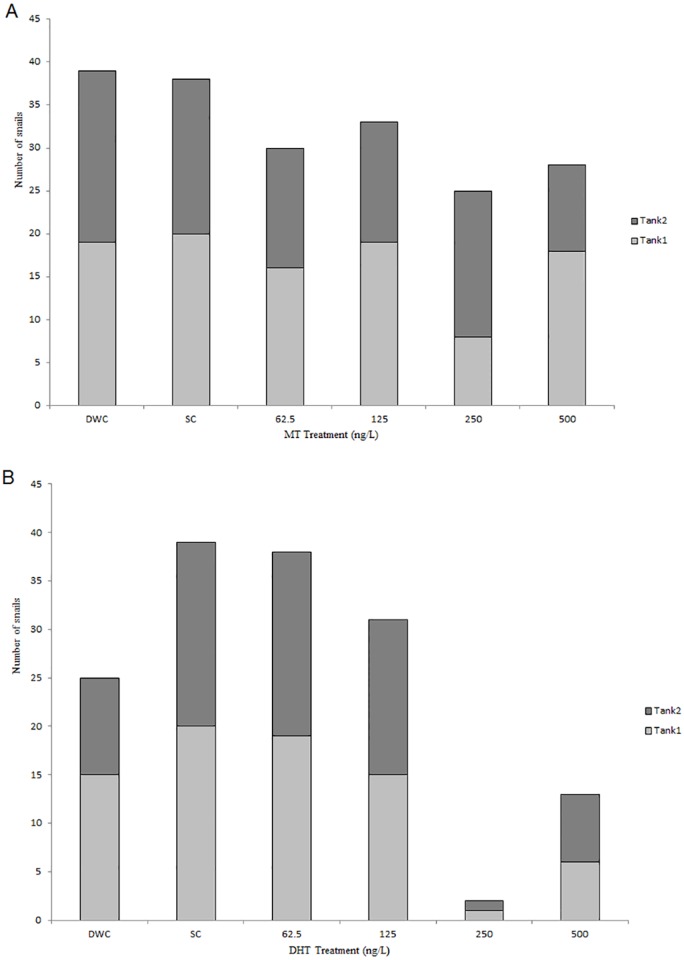
Number of B. glabrata per tank after 30-day exposure to methyltestosterone (A) or dihydrotestosterone (B).At the start of the experiment 20 hatchling snails were placed into each replicate tank (two tanks per treatment). Stacked bars represent the number of snails surviving in replicate tanks to the end of the 30-day developmental exposure. Treatments;—Dilution Water Control (DWC), Solvent Control (SC) and 62.5, 125, 250 and 500 ng/L of either MT or DHT.